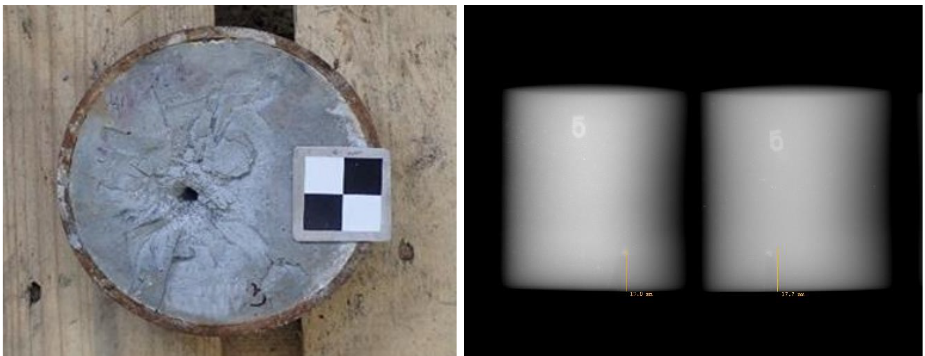
Fig. 3 Test sample R – 3 after the projectile penetration test (left) and X-ray photo of backing